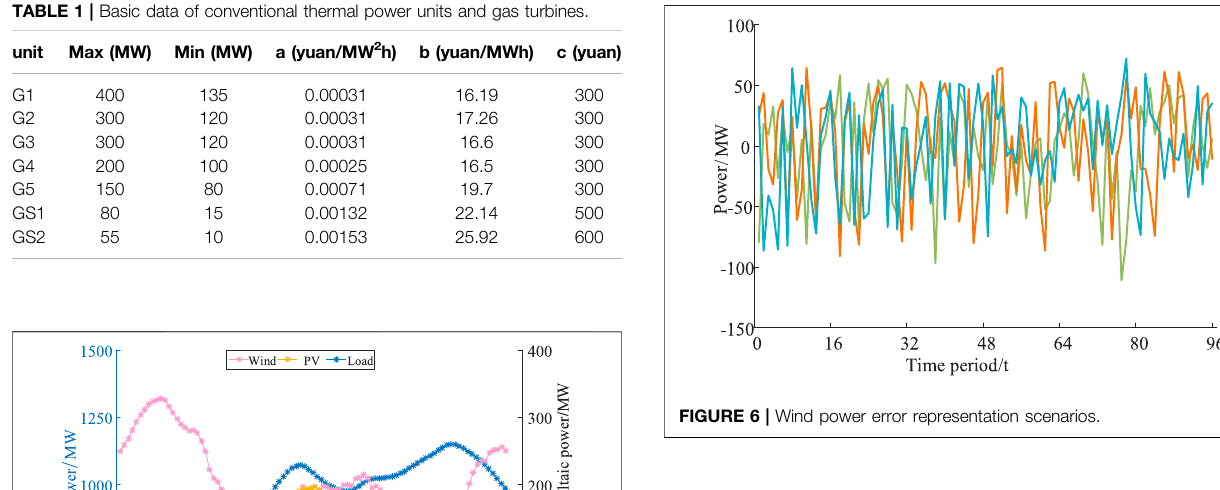
Table 1 . A pumped storage power plant with an installed capacity